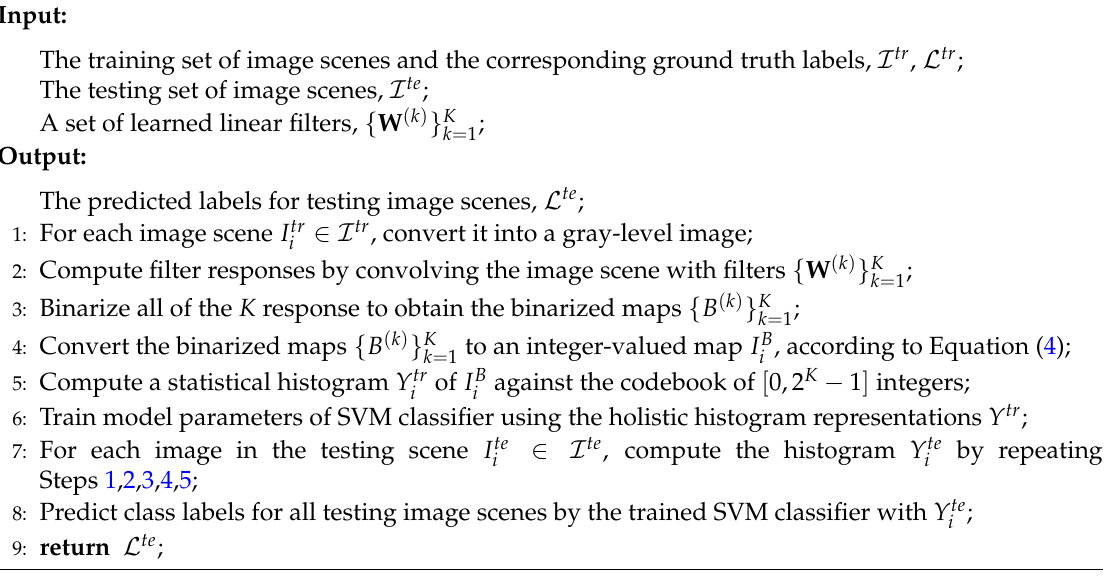
Algorithm 1 FBC-based scene classification